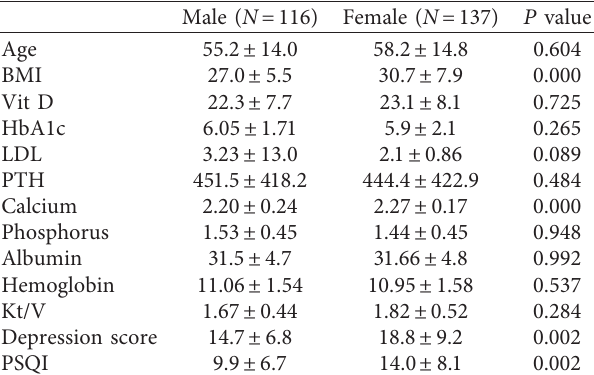
Table 5: Comparison between male and female patients according to different parameters.